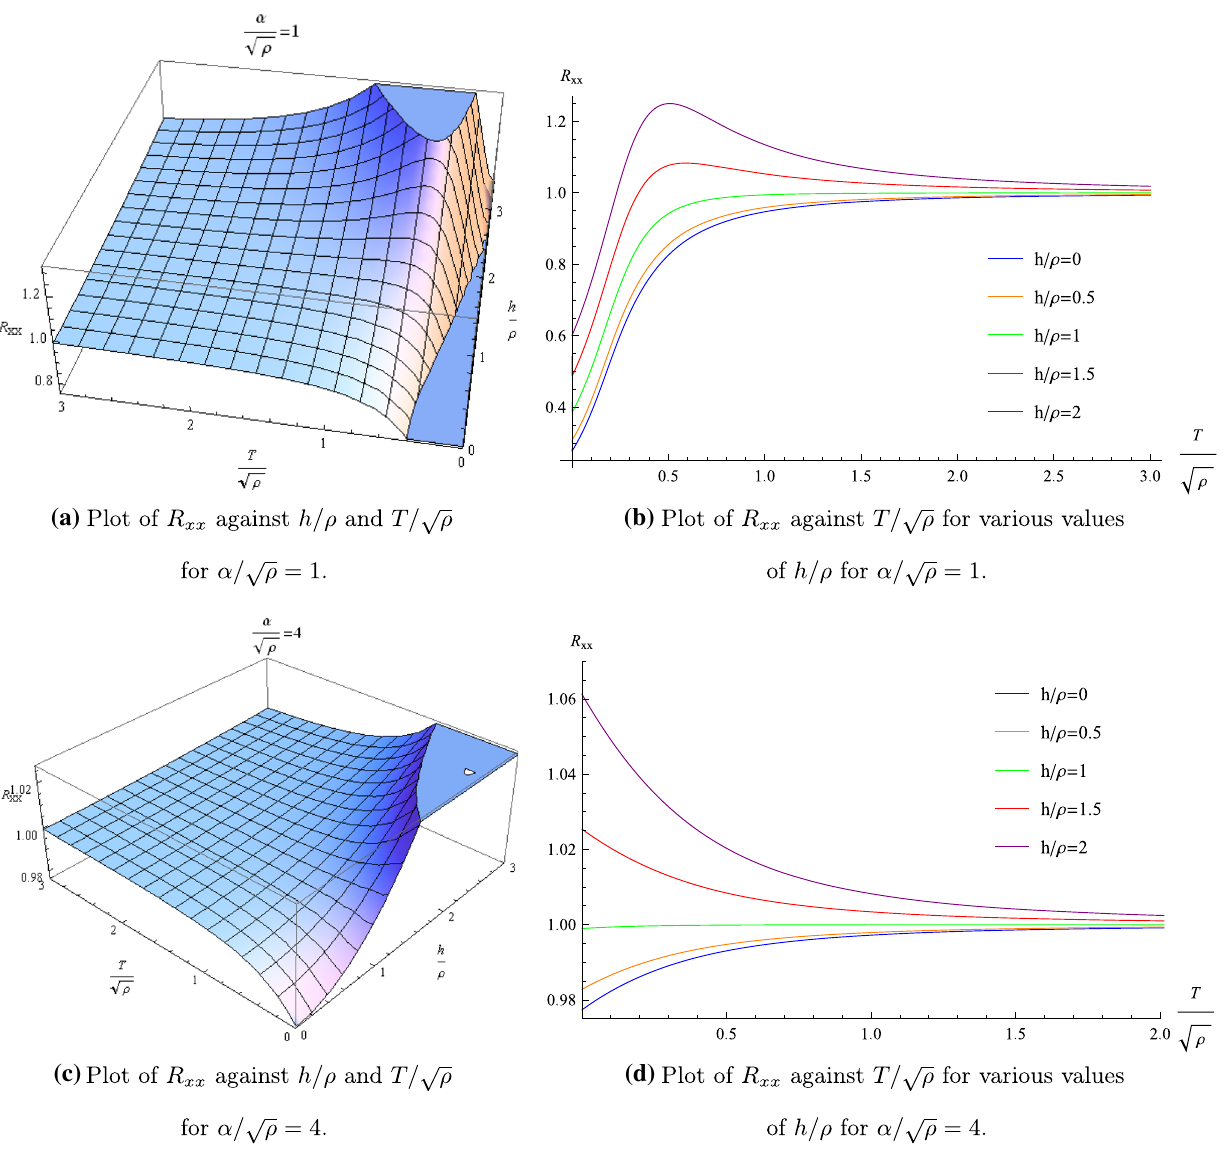
√ √ ρ = 1 and α/ ρ = 4 for Maxwell